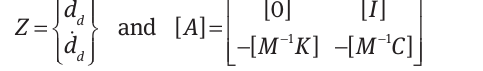
= 14 μ m, l = l /3, n = 1, m c m